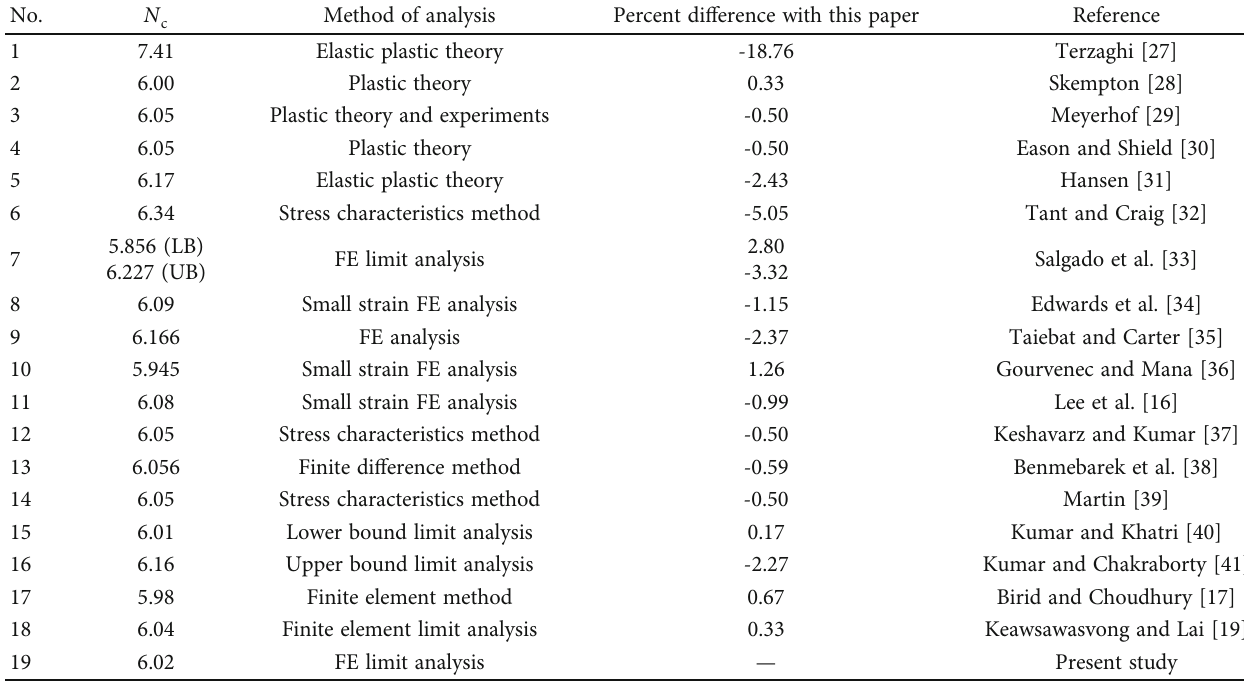
of the circular c